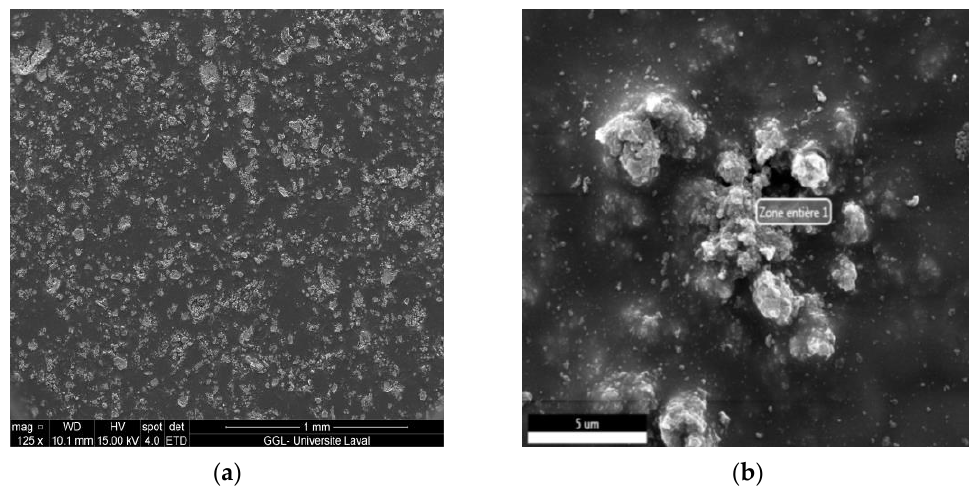
Figure 9. ( a ) SEM image of SS with a TiO 2 -based coating (×125); ( b ) SEM image of SS with a TiO 2 -based coating (×6000 magnification).